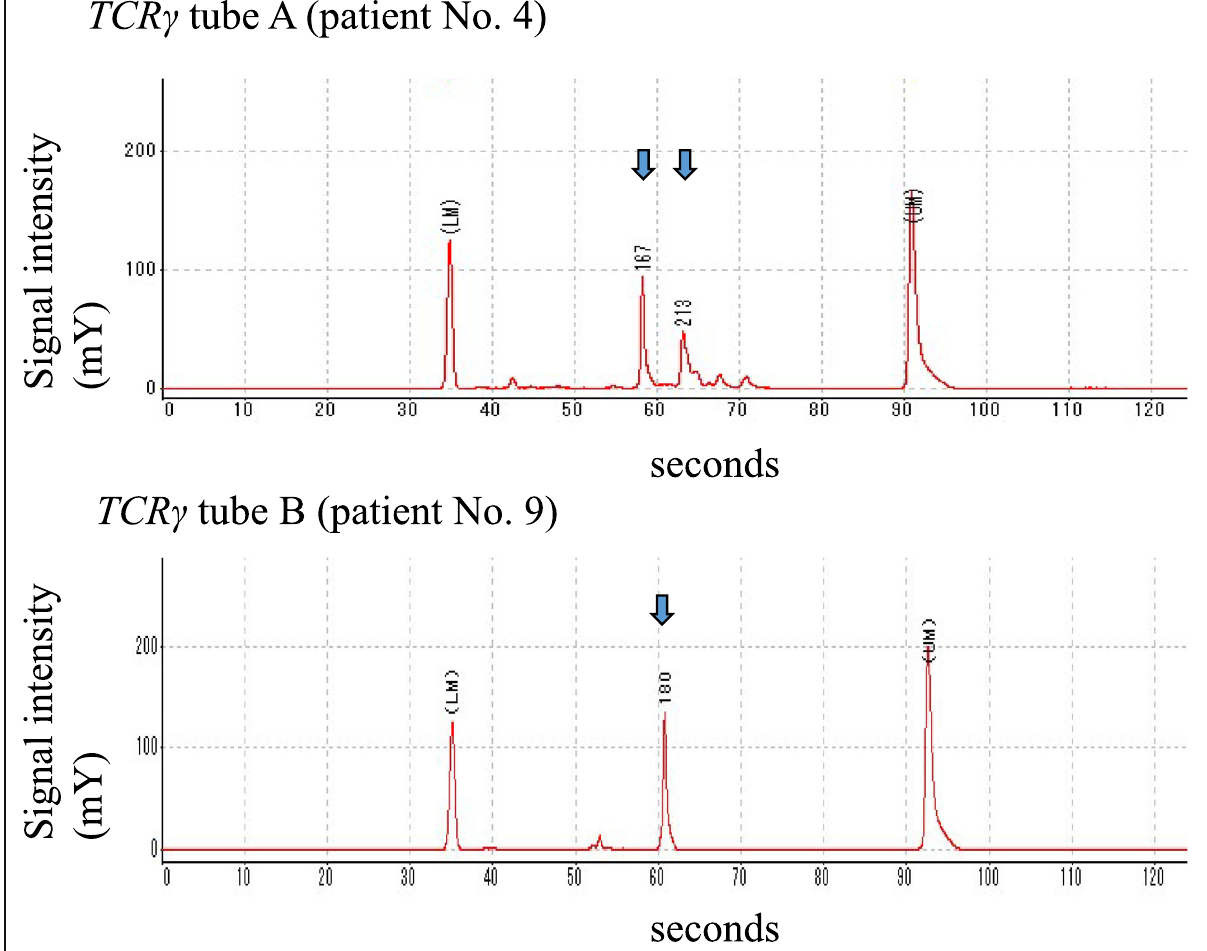
Fig. 4 T-cell receptor (TCR) γ gene analysis by PCR. Clonal peaks (arrows) of the TCR γ gene VJ and DJ regions (Tubes A, B) detected by GeneScan analysis in patient Nos. 4 and 9, respectively. The lower marker (LM) and upper marker (UM) are spiked as internal